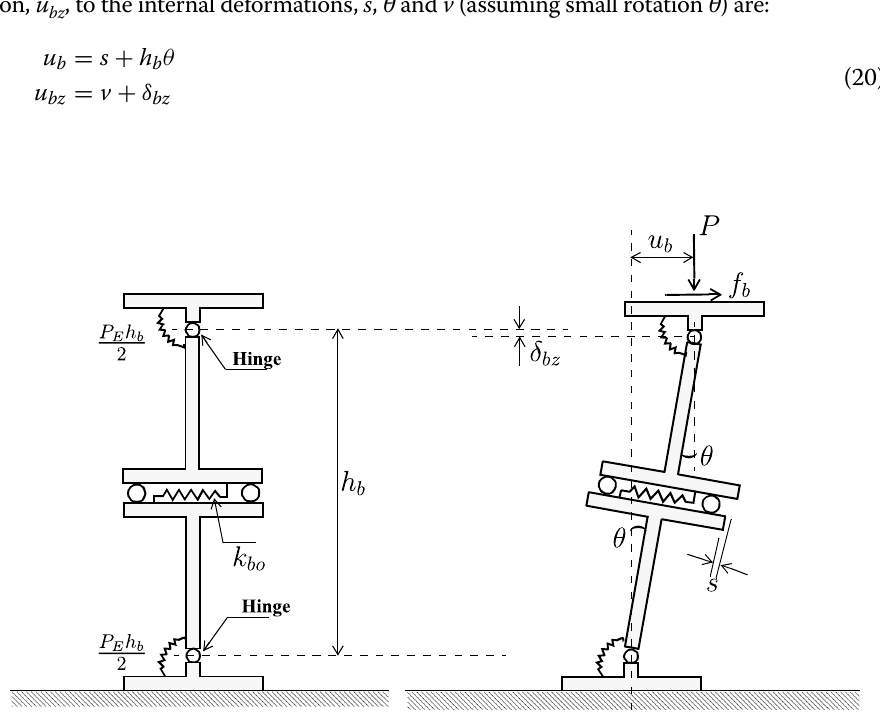
Fig. 4 Two-spring model of an isolation bearing in the undeformed and deformed configuration (Source: (Ryan and Chopra